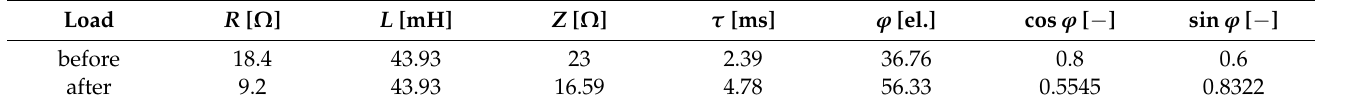
Table 25: Table 25. Load parameters for steady states before and after load change.